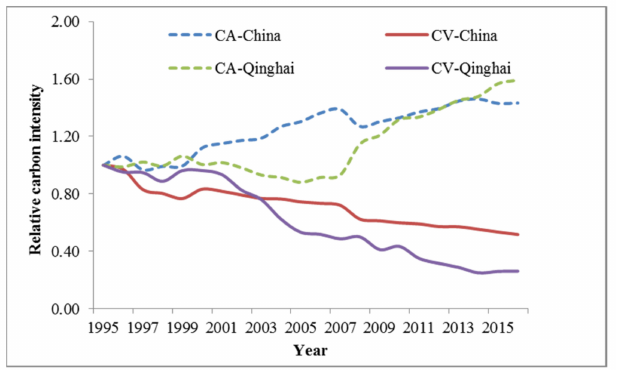
Figure 7. Change in relative carbon intensity in Qinghai province and China over 1995–2016.